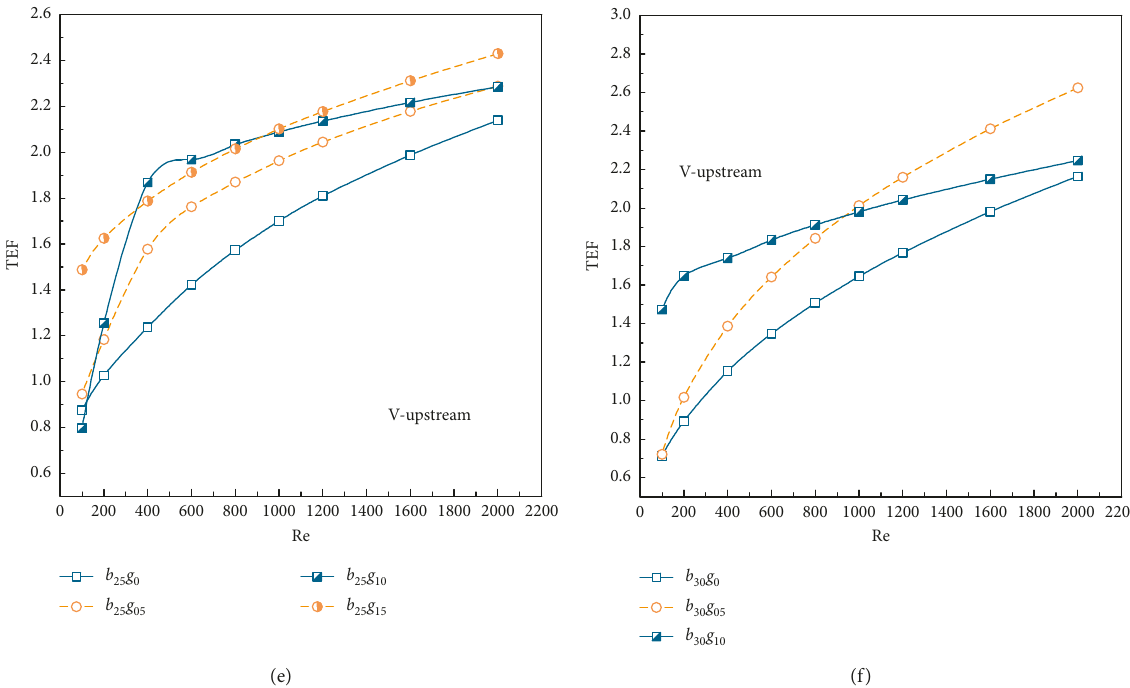
Figure 16: Relation of the TEF with the Reynolds number for (a) b05, (b) b10, (c) b15, (d) b20, (e) b25, and (f) b30 at V-upstream